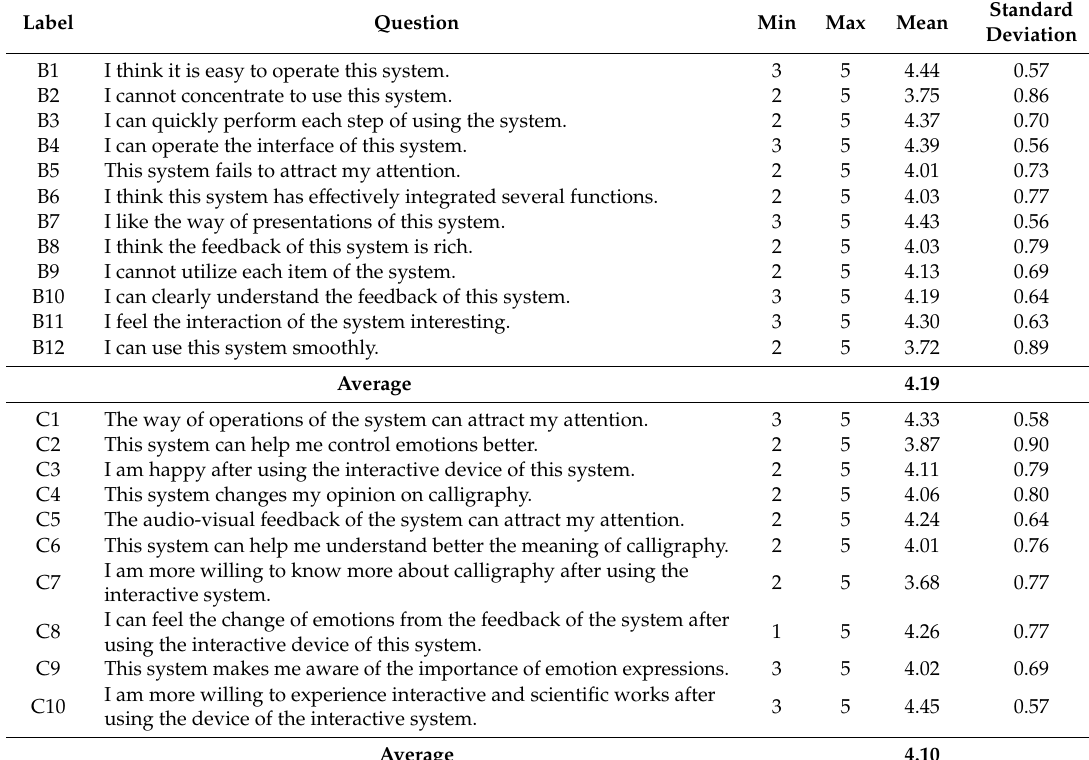
Table 12. Statistics of the collected data of the two indicators of system usability and writer’s experience. Question Min Max Mean